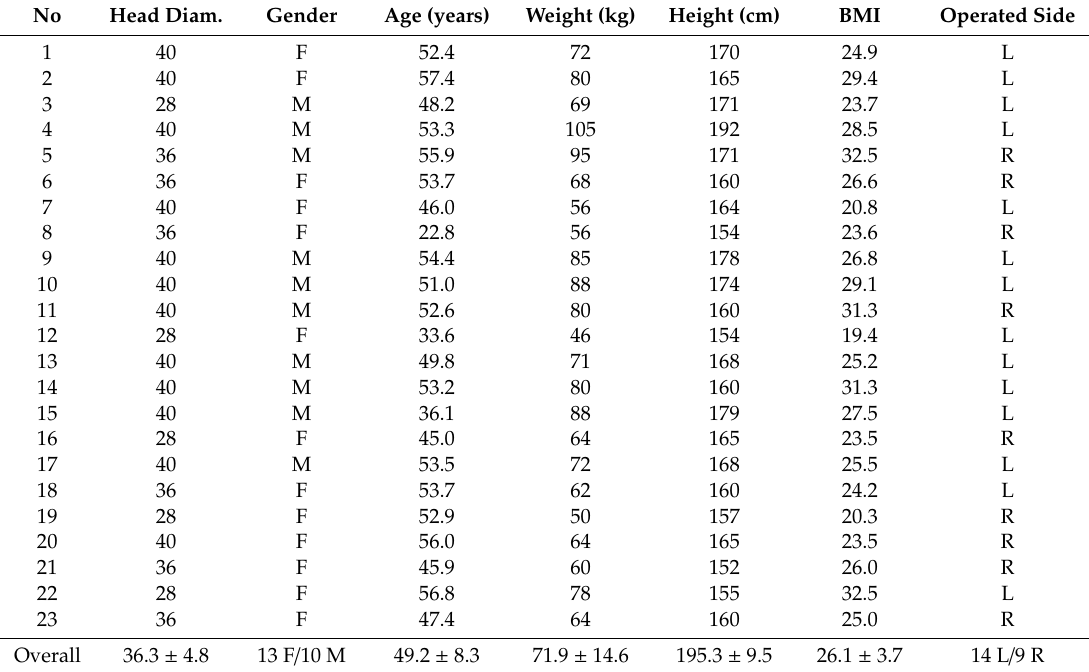
Table 1. Demographical data. The total number of female (F) and male (M) participants, as well as the total left (L) and right (R) operated knee sides, are reported in the last row, along with the mean ± standard deviation values for all patients when appropriate. BMI: Body Mass